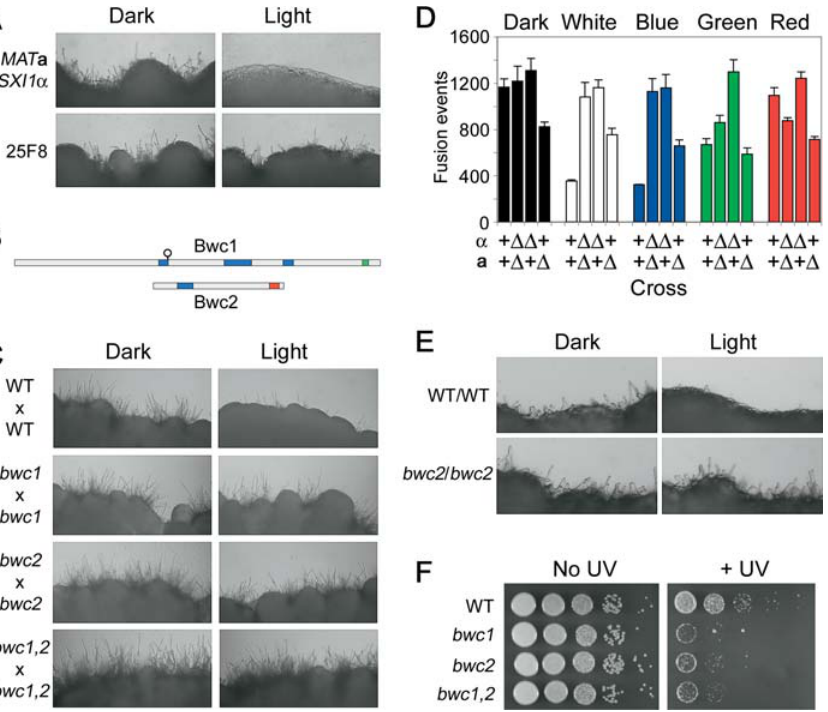
Figure 5. The BWC2 Gene also Mediates UV/Blue Light Responses in C. neoformans